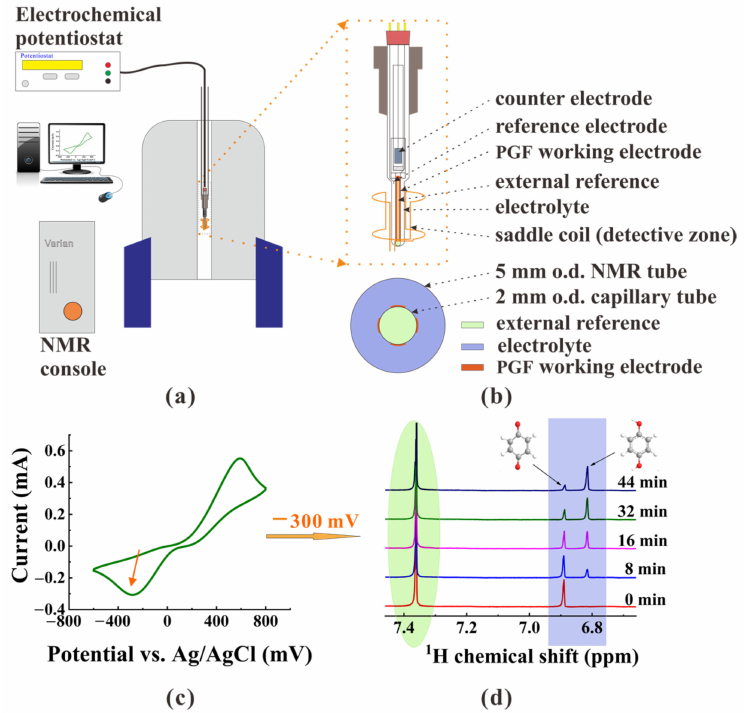
Figure 1. ( a ) Schematic of an in situ electrochemical quantitative nuclear magnetic resonance (EC-qNMR) setup. ( b ) Sectional view of the EC-qNMR cell, wherein the NMR effective detec- tion zone. ( c ) Cyclic voltammogram of p-benzoquinone with a palisade gold film (PGF) electrode system in an acid solution. ( d ) In situ NMR spectra of the redox of p-benzoquinone at a potential of − 300 mV, where the colors of the spectrum marker correspond to the compound in subgraph ( b